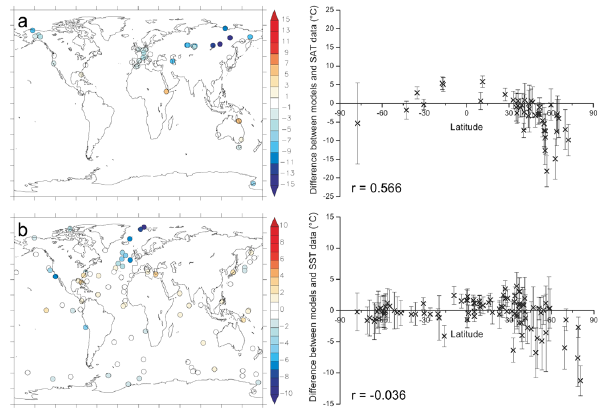
Fig. 5. Point-based data/model comparison of (a) surface air tem- perature and (b) sea surface temperature anomalies (modelled warming minus proxy data Pliocene warming) for Experiment 2. Error bars on the scatter plots refer to the 2 σ range derived from the Experiment 2 ensemble, while r is the Pearson correlation co- efficient between the modelled Pliocene warming anomaly and the data derived warming